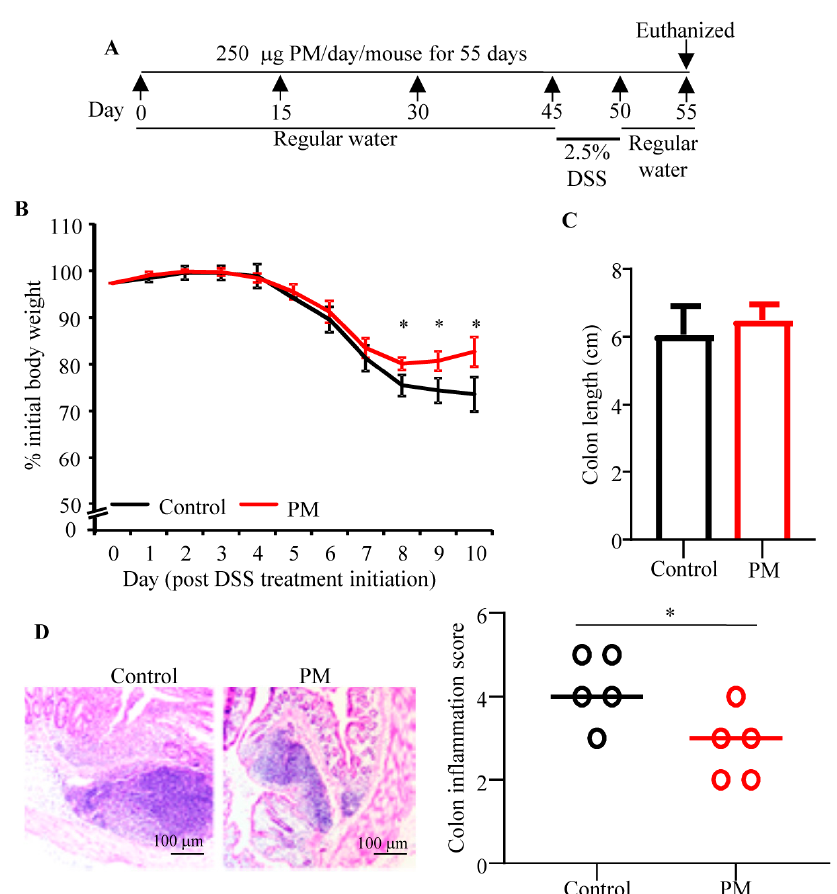
Figure 5. Impact of pre-treatment with PM on susceptibility to DSS-induced colitis. B6 mice were treated as depicted in panel ( A ). Bodyweights of individual mice were measured starting pre-DSS treatment (day 45) every day and mean ± SD values of changes in total body weights, relative to initial body weight ( n = 5 / group) are shown ( B ). p -value by unpaired t -test for each time-points. Mice were euthanized on day 55, colons were harvested, and their length was measured and mean ± SD values of length of colons from 5 mice / group are shown ( C ). H&E stained distal colon sections were evaluated for the degree of inflammation and representative images of sections (left panel) and mean ± SD values of inflammation severity scores of 5 mice / group (right panel) are shown ( D ). p -values by Fishers’ exact test comparing number of mice with grade ≤ 3 and ≥ 4 inflammation scores. * p <